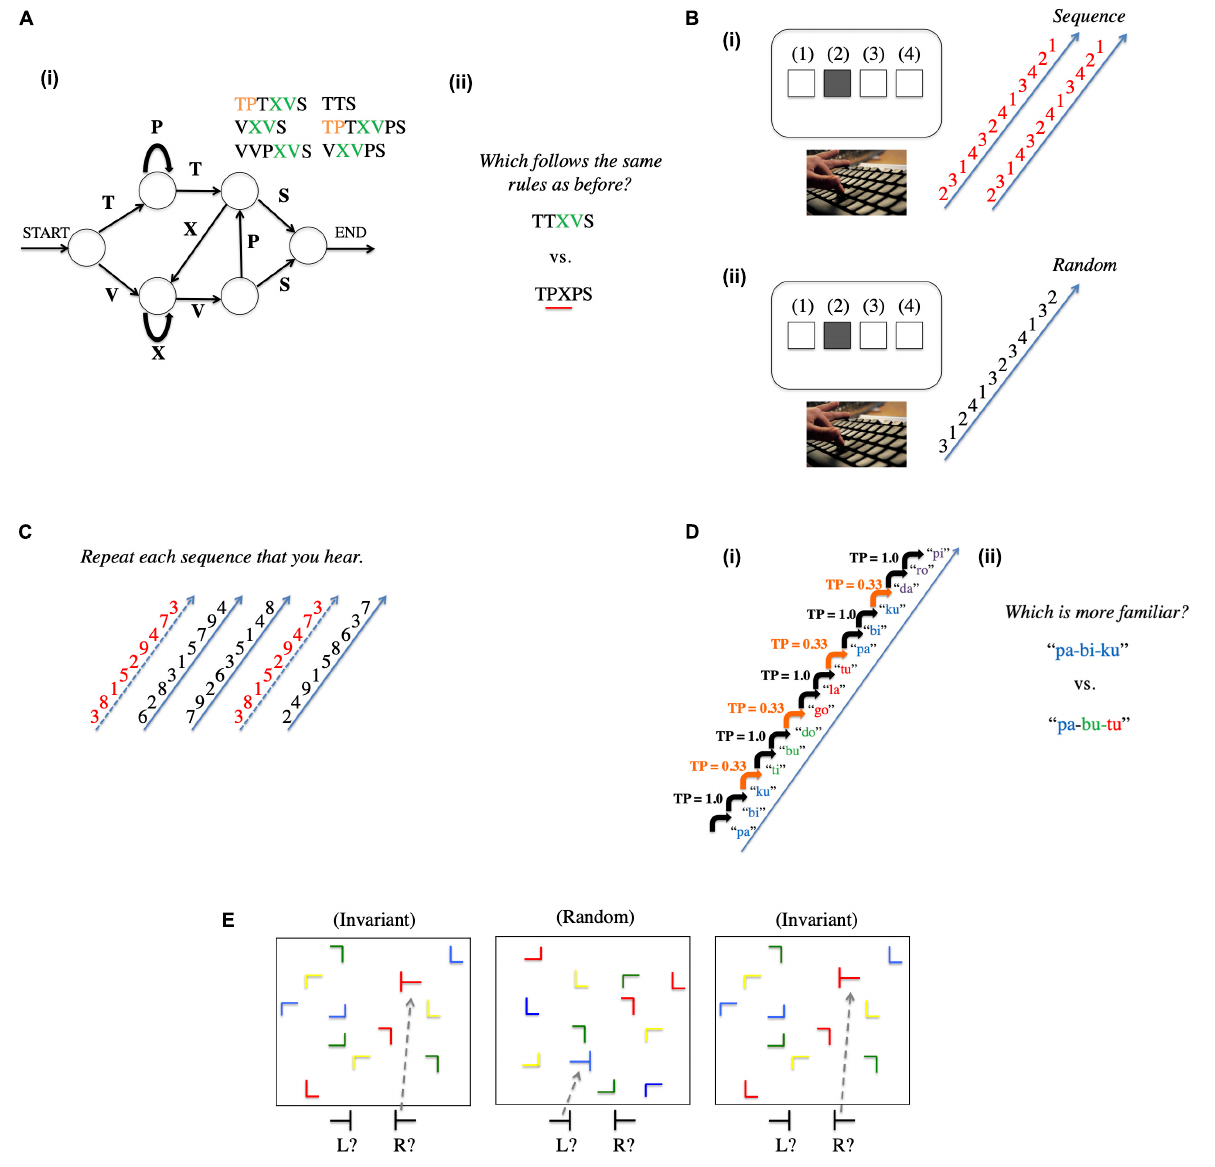
Frontiers in Human Neuroscience |